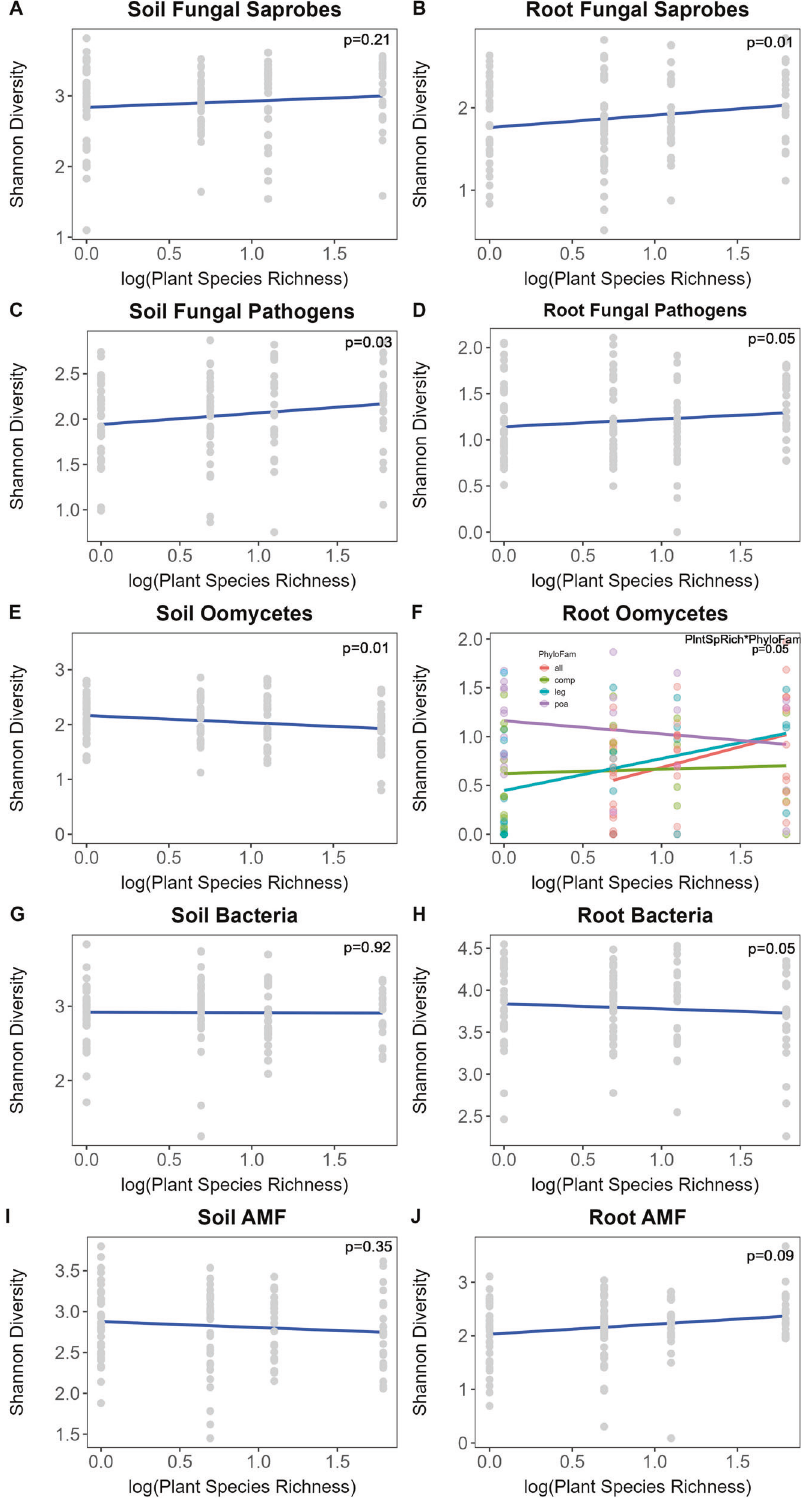
Fig. 3 Microbial diversity response to plant species richness treatment. Regression of ( a ) soil ( p > 0.1) and ( b ) root fungal saprotroph diversity ( p = 0.01), ( c ) soil ( p = 0.03) and ( d ) root ( p = 0.05) pathogenic fungal diversity, ( e ) soil ( p = 0.01) and ( f ) root ( p = 0.05, interaction with family treatment) oomycete diversity, ( g ) soil ( p > 0.1) and ( h ) root ( p = 0.05) bacteria diversity, ( i ) soil ( p > 0.1) and ( j ) root ( p = 0.09) AMF diversity in response to the log-transformed planted species richness treatment. Diversity responses were adjusted when plant family composition or block had signi fi cant responses. P -values reported are from GLM of microbial diversity response to the model, as shown in detail in Table